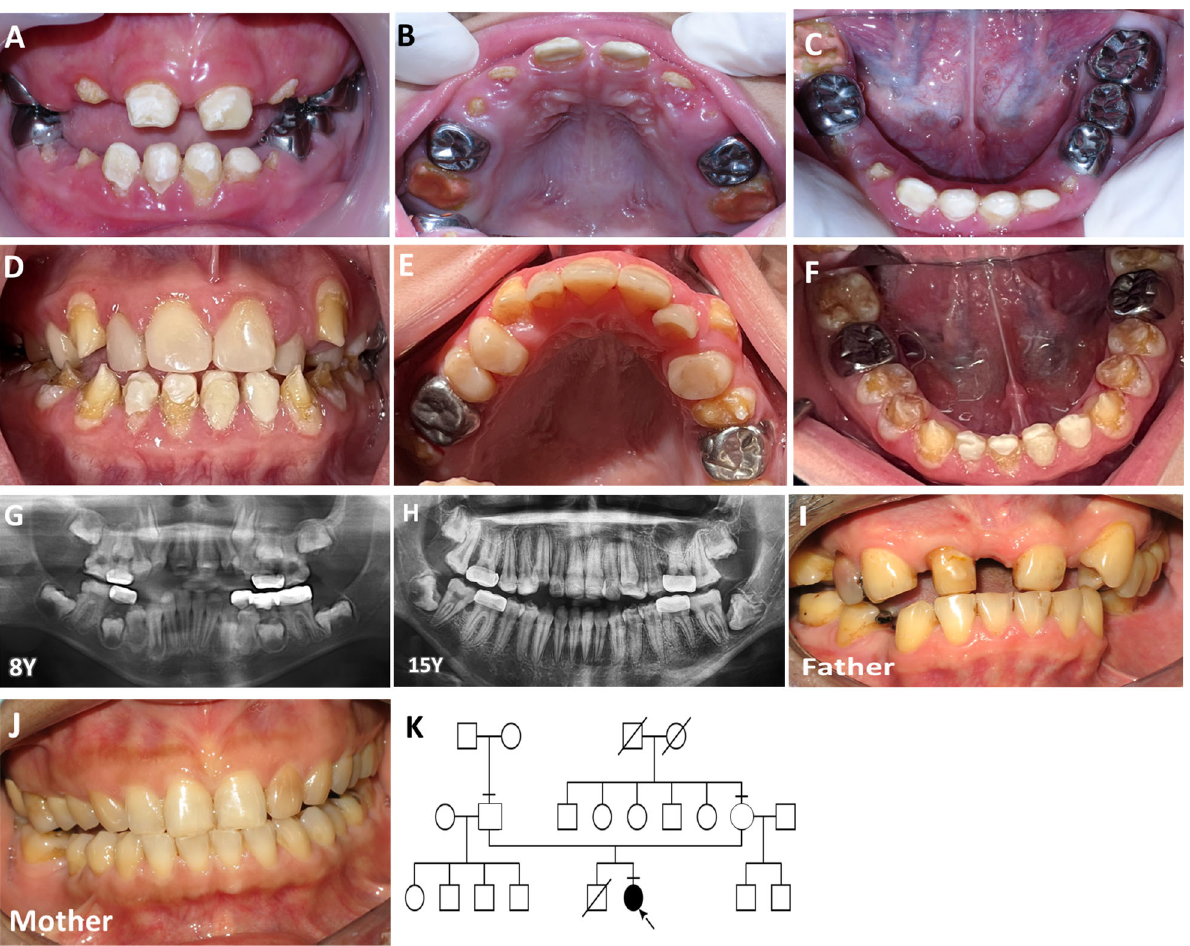
Fig. 1 Clinical and radiographic feature, family pedigree, and chromatograms of the patient and family. A – C Orodental features of the proband at 8-year-old showed yellow teeth with rough and pitted enamel. The deciduous molars were restored with stainless steel crowns. D – F Orodental features of the proband at 15-year-old showed dark yellow teeth with rough enamel that was severely eroded. A band of enamel was observed along the cervical margin and cusp tips of the teeth. G , H Panoramic radiographs showed a reduction in thickness and radiodensity of enamel. Taurodontism was observed in the permanent maxillary second molars. The permanent fi rst molars showed bone loss. I , J The parents did not have enamel defects. K Family pedigree showed that the proband (arrow) was the only person in the family with enamel